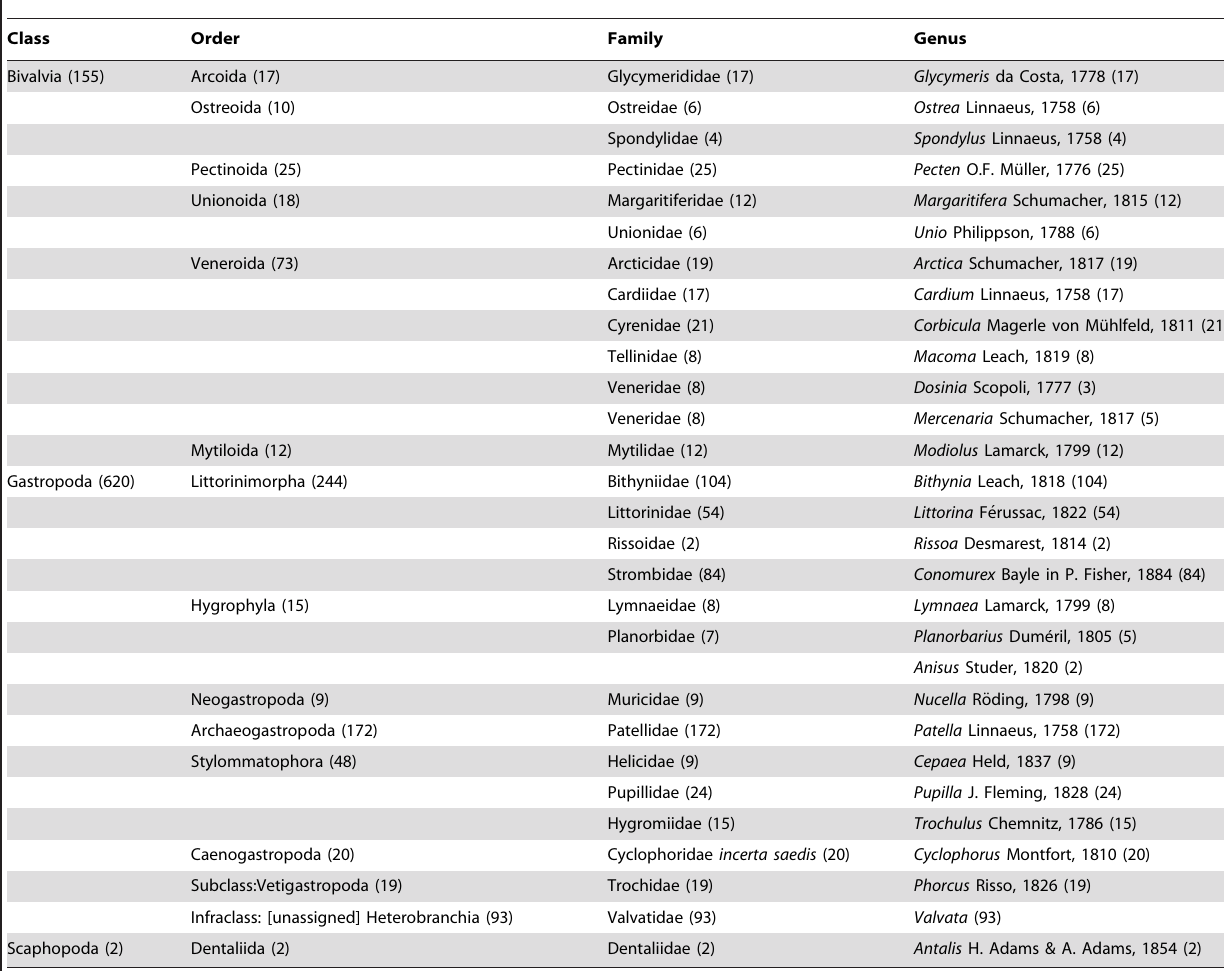
Table 1. Details of the molluscan